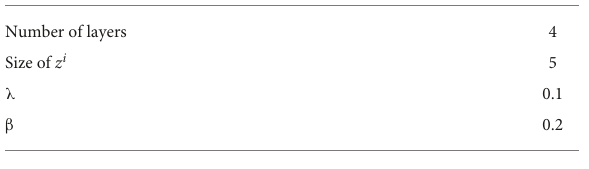
TABLE 3 Results of TC